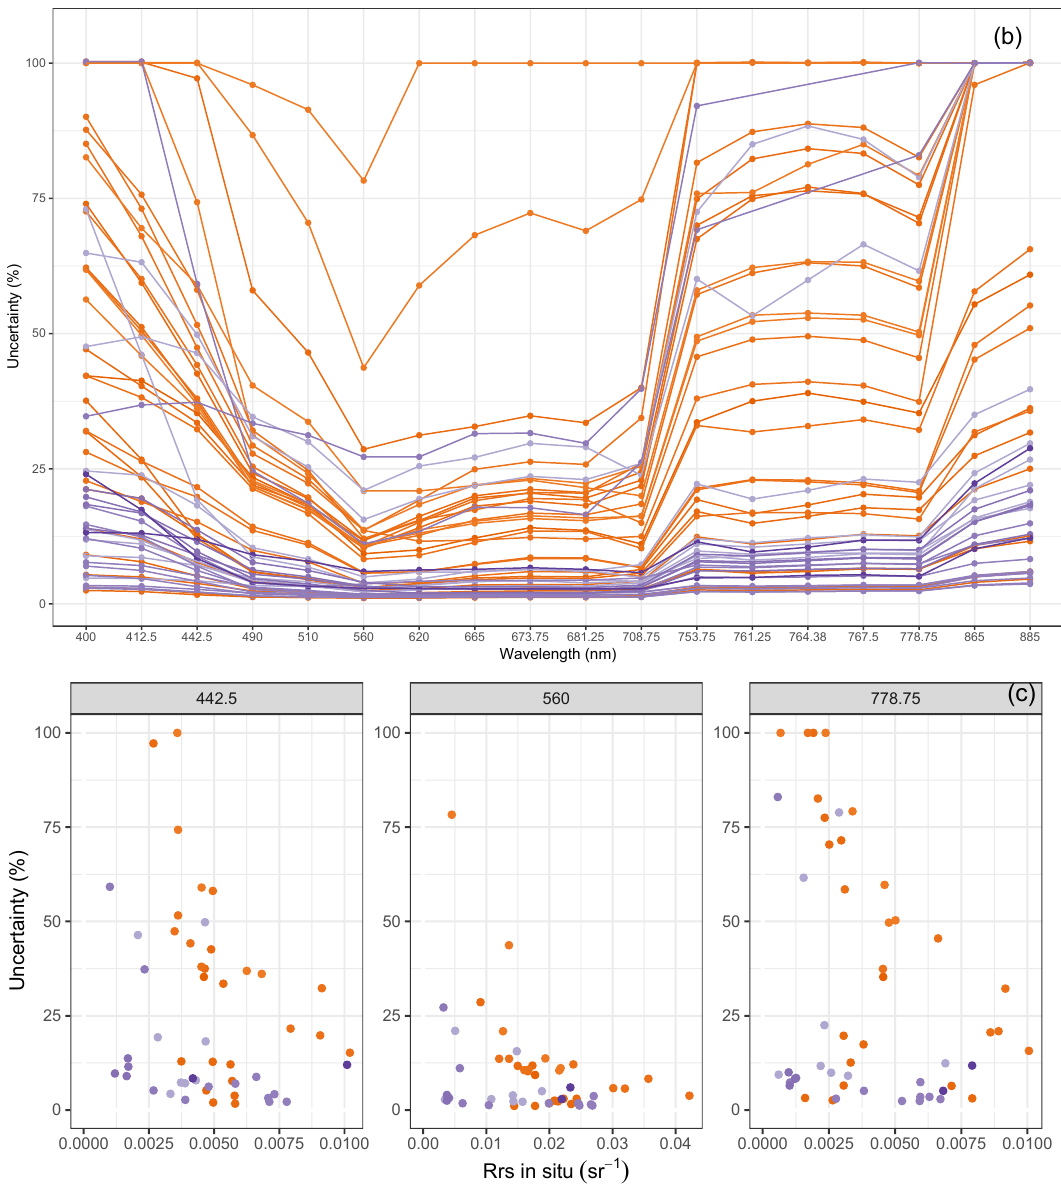
Figure 1. In situ measured water-leaving reflectance after processed with ( a ) S3A Ocean and Land Colour Instrument (OLCI) SRF, ( b ) calculated full uncertainty budget for each band and relationship between ( c ) R rs and uncertainty in selected